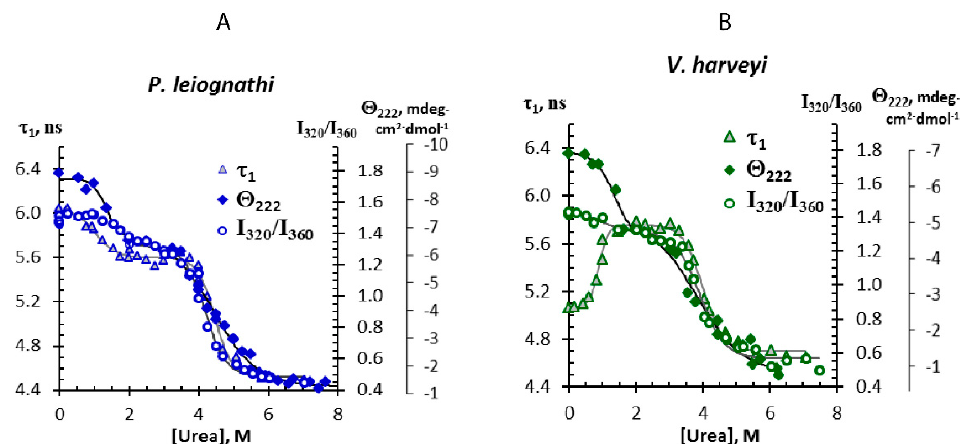
Figure 2. Comparison of the optical parameter changes in equilibrium unfolding of P. leiognathi ( A ) and V. harveyi ( B ) luciferases obtained by different methods: the ratio I 320 /I 360 ( ), molar ellipticity at 222 nm, Θ 222 , ( ) and the fluorescence lifetime component τ 1 ( ). Solid lines represent fitting to a double Boltzmann function.